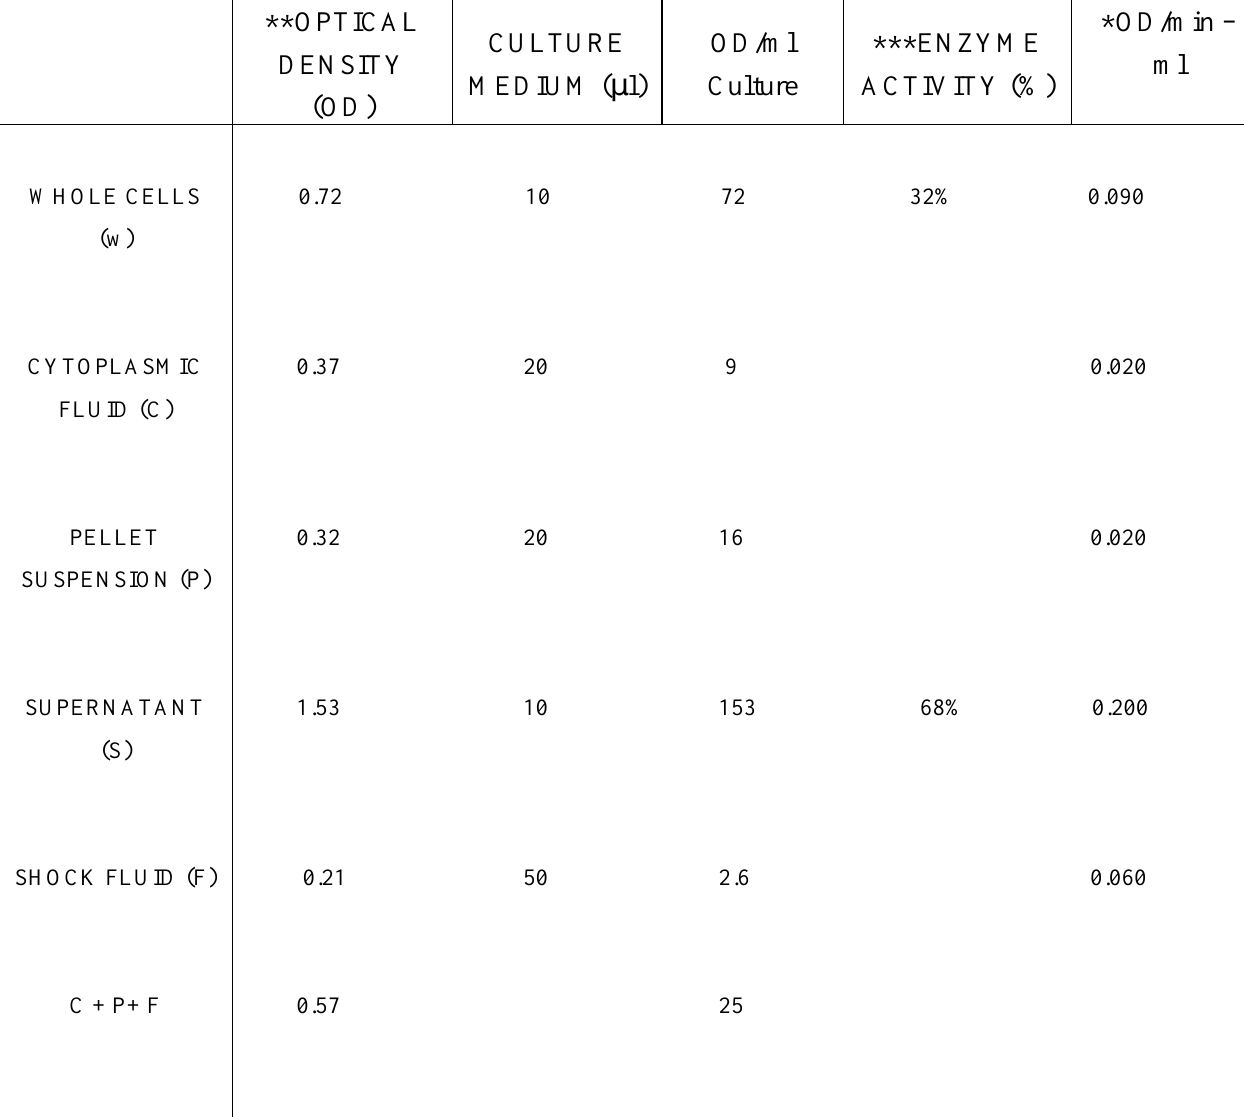
Table 2. Hydrolysis assay of different cell fractions separated from C. hutchinsonii cells grown on solka flok (cellulose) as the carbon